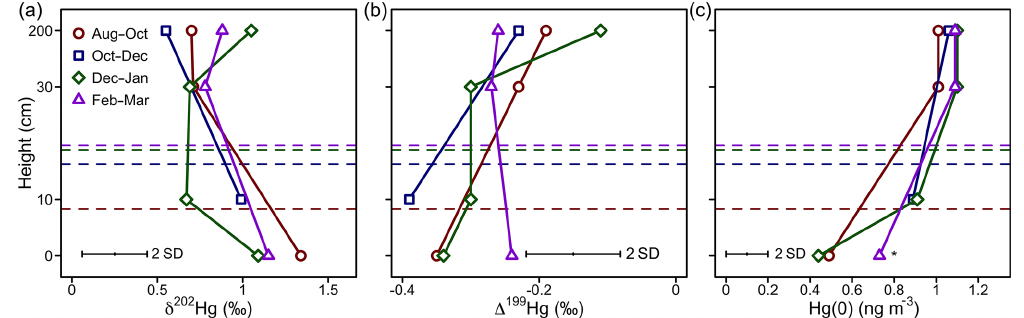
Figure 2. Hg(0) measurements in interstitial snow air profiles. (a) Mass-dependent fractionation stable isotope signature of Hg(0) ( δ 202 Hg), (b) mass-independent fractionation stable isotope signature of Hg(0) ( (cid:49) 199 Hg), and (c) mean Hg(0) concentration. Note that the Hg(0) concentration marked with an asterisk ( ∗ ) was calculated from Hg recovered on the IAC traps, whereas other Hg(0) concentration profiles were measured by an automated trace gas system deployed in the snowpack (Agnan et al., 2018). The dashed horizontal lines represent the average snow height during the respective